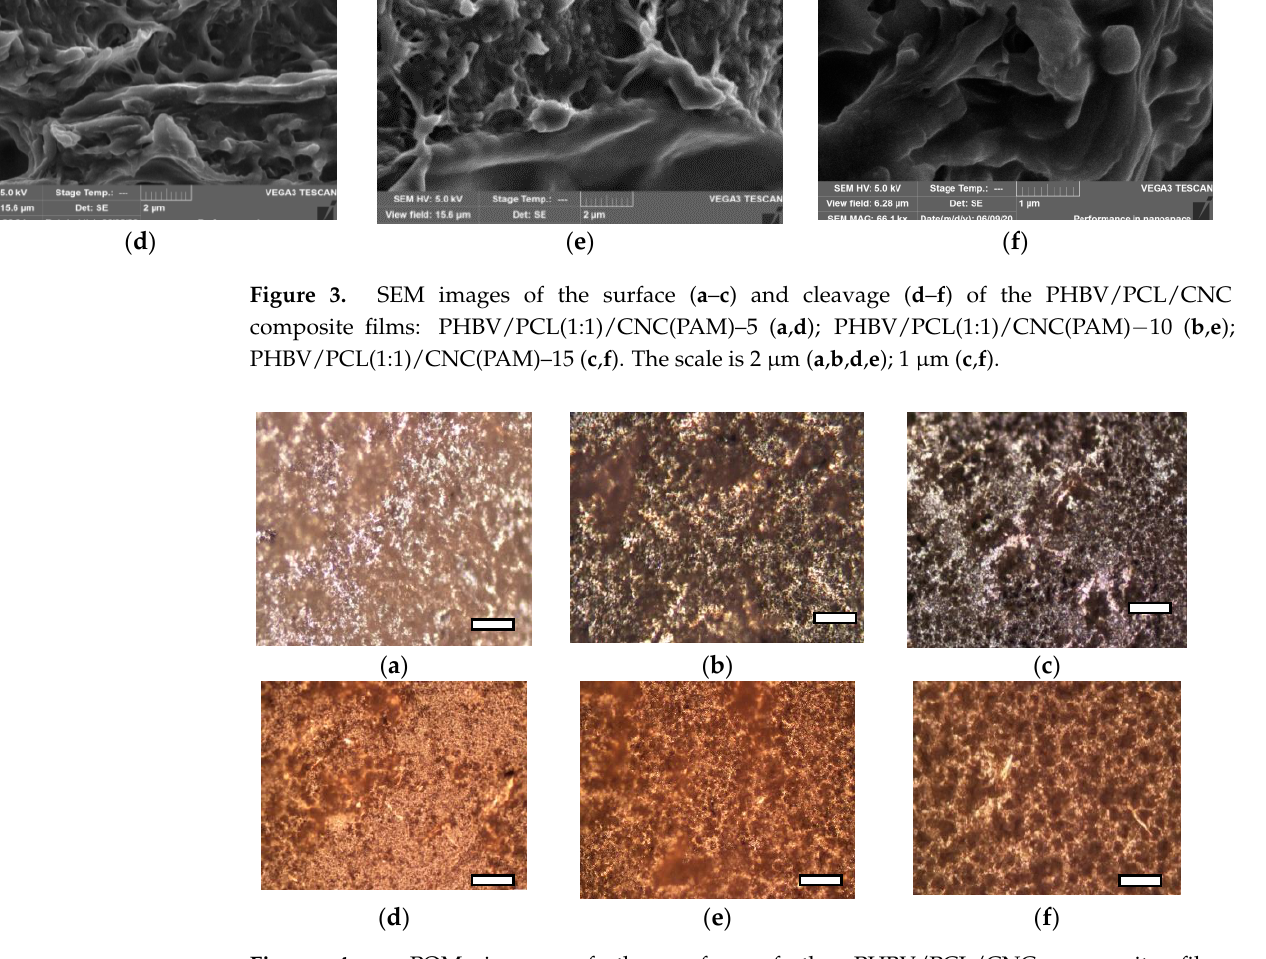
Figure 4. POM images of the surface of the PHBV/PCL/CNC composite films: PHBV/PCL(1:1)/CNC(PVP)–5 ( a ); PHBV/PCL(1:1)/CNC(PVP)–10 ( b ); PHBV/PCL(1:1)/CNC(PVP)–15 ( c ); PHBV/PCL(1:1)/CNC(PAM)–5 ( d ); PHBV/PCL(1:1)/CNC(PAM)–10 ( e ); PHBV/PCL(1:1)/CNC(PAM)–15 ( f ). The scale is 100 μm. Table 1. Specific surface area and water vapor sorption on PHBV/PCL and PHBV/PCL/CNC films. Sample BET Specific Surface